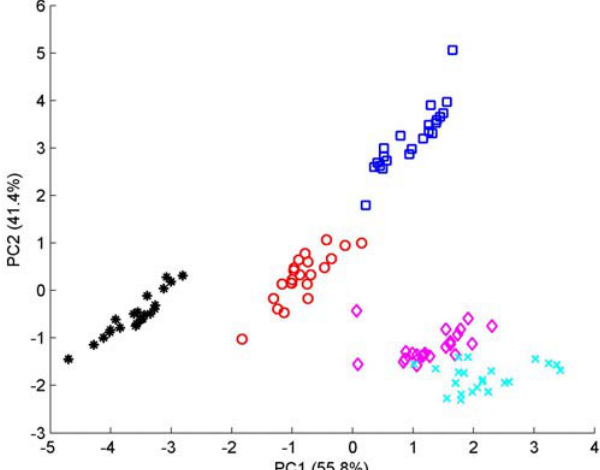
Figure 8. The 2D-PCA plot of five classes of green tea derived from five different provinces of